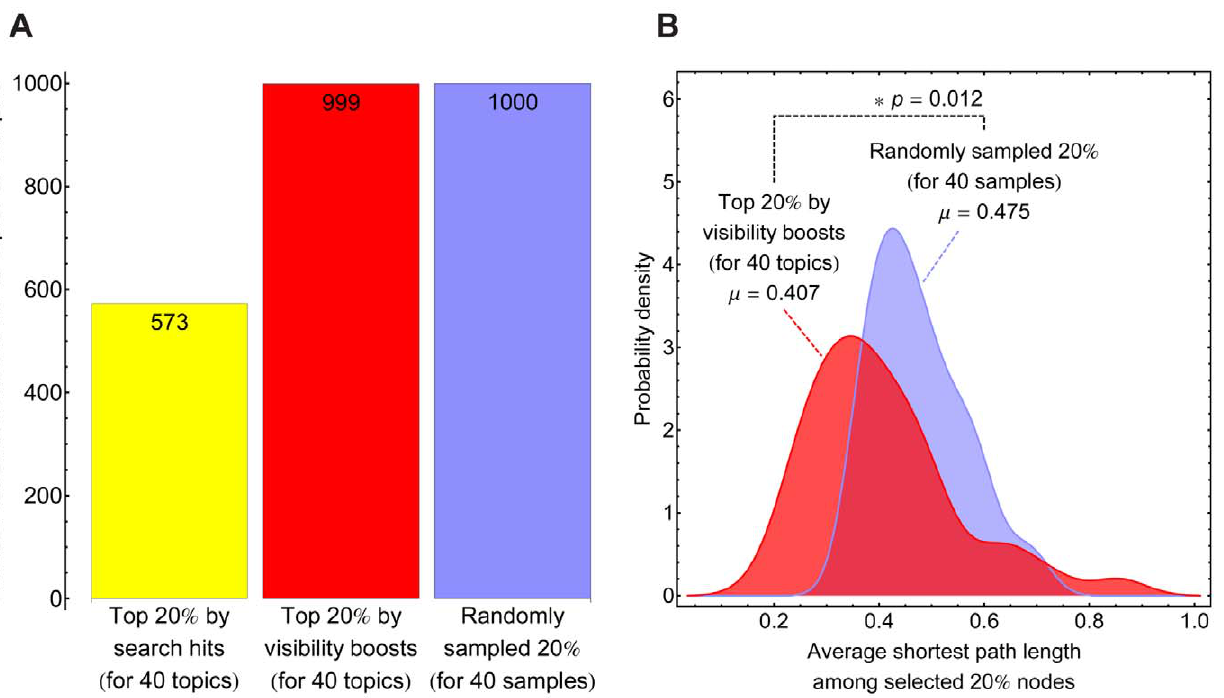
Figure 4. Use of visibility boosts. (A) Comparison of the numbers of nodes (researchers) that appeared at least once in 40 times of selection trials. Yellow: Top 20% nodes selected based on their original search hit counts for each of the 40 research topics. Red: Top 20% nodes selected based on their visibility boosts by each of the 40 research topics. Blue: Random selection of 20% nodes repeated 40 times. (B) Smoothed histograms of average shortest path lengths among the selected 20% nodes in the researchers’ network ( N =40 for each histogram; each sample point corresponds to one measurement of average shortest path length among the selected 20% nodes). To calculate path lengths, the reciprocals of link weights were used as edge distances. The average shortest path lengths among the top 20% nodes selected based on their visibility boosts were significantly smaller than random counterparts ( p , 0.05 by standard t -test), showing that researchers who share high visibility boosts by the same topic tended to come closer to each other in the